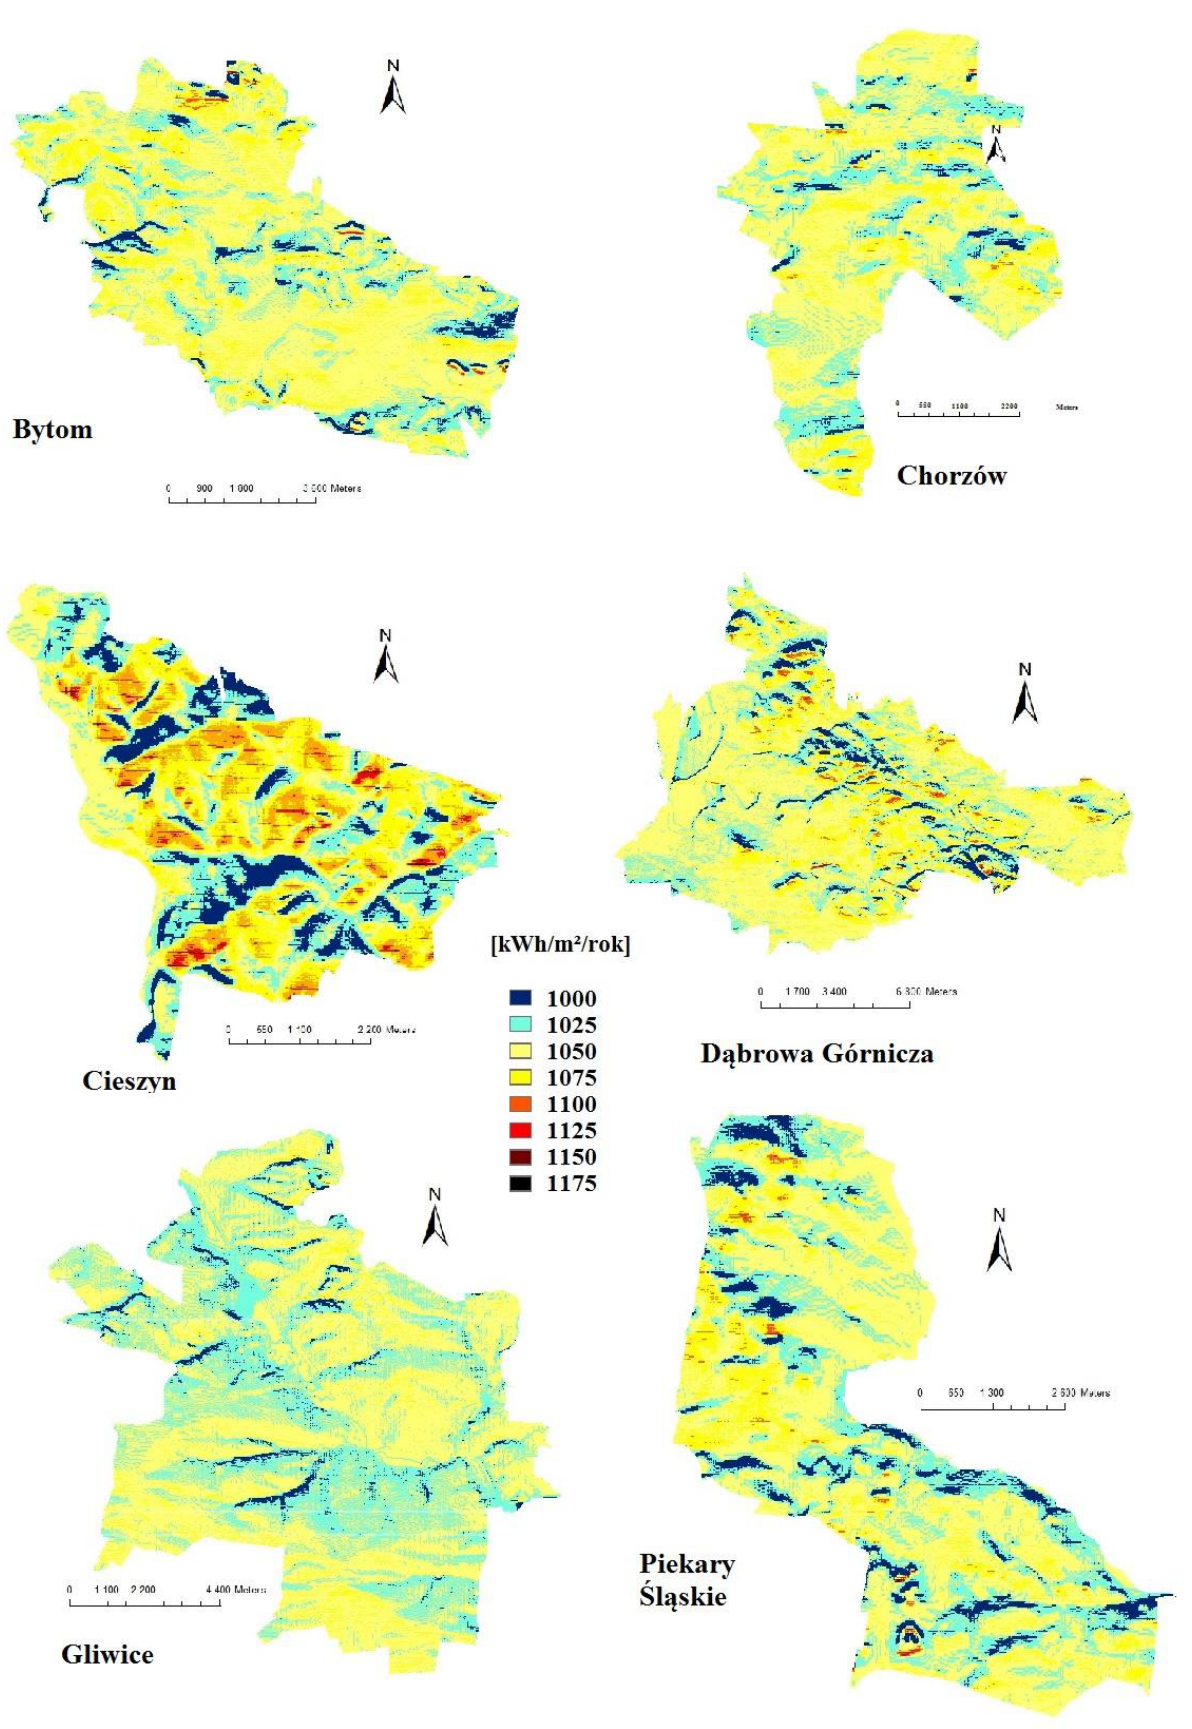
Fig. 4. Theoretical potential of global solar radiation (kWh·m -2 ) in selected districts in the Silesia